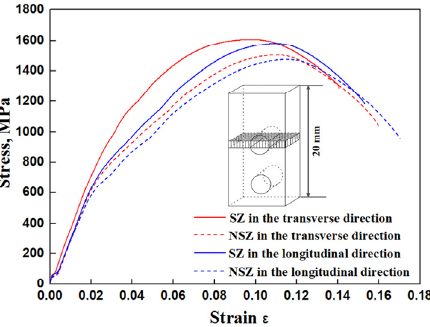
4 of 14 Figure 2. Crack morphology in a segregation zone (SZ) on the flame cutting surface. ( a ) Optical microscopy image and ( b ) scanning electron microscopy image. 3.2. Tensile Properties The stress–strain curves are shown in Figure 3. Table 1 shows the tensile properties